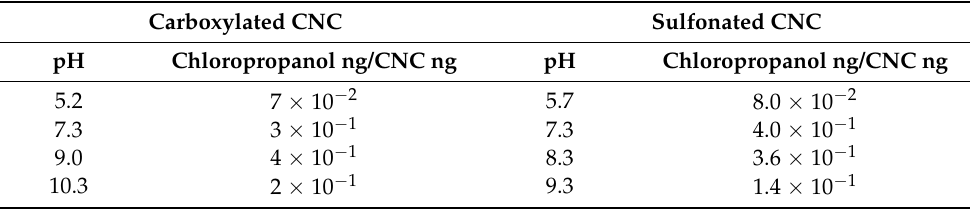
Table 1. Saturated adsorption capacity of chloropropanol on